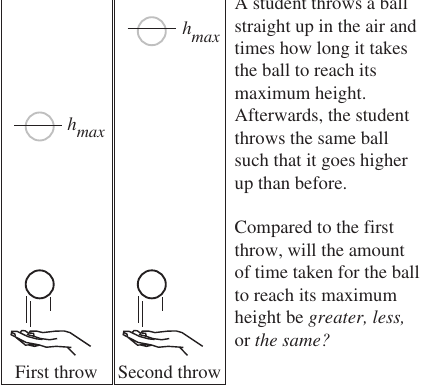
FIG. 5. Vertical toss question: distance